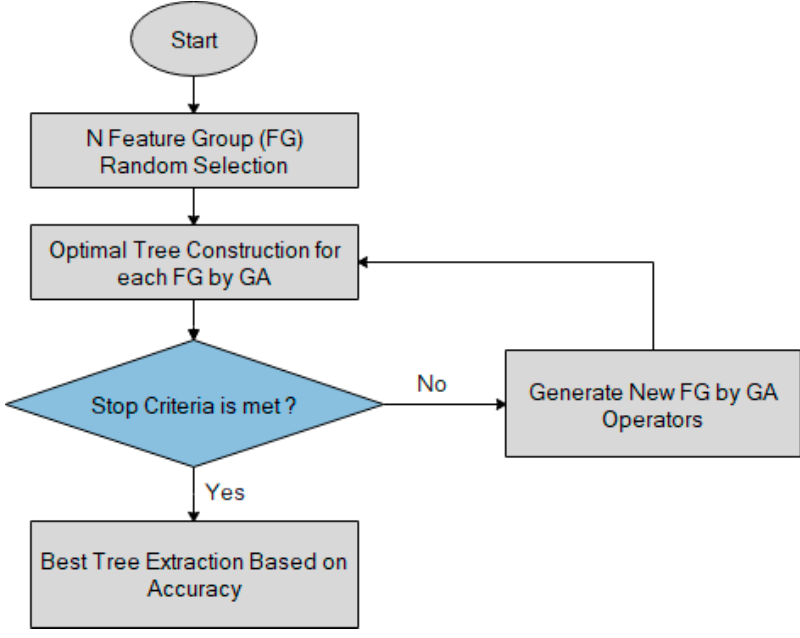
Figure 6. Process of genetic algorithm (GA).